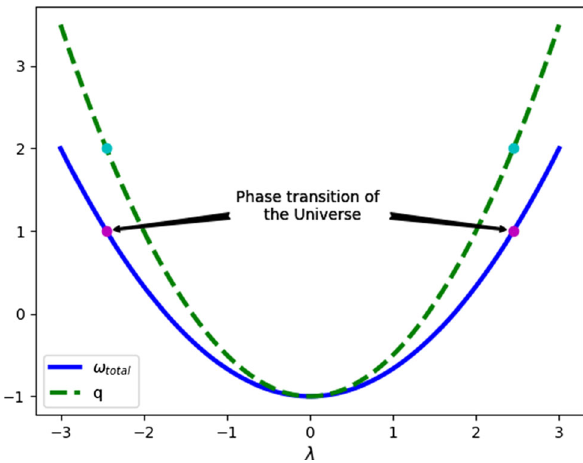
Fig. 14 Phase transition of the universe at the bifurcation values λ = ±√